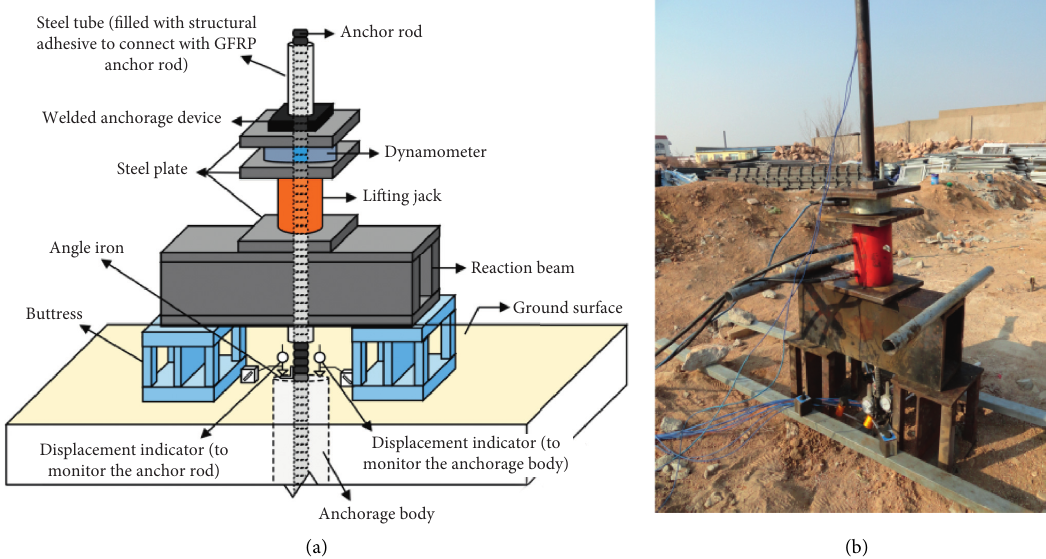
Figure 8: Loading device: (a) schematic diagram and (b) realistic